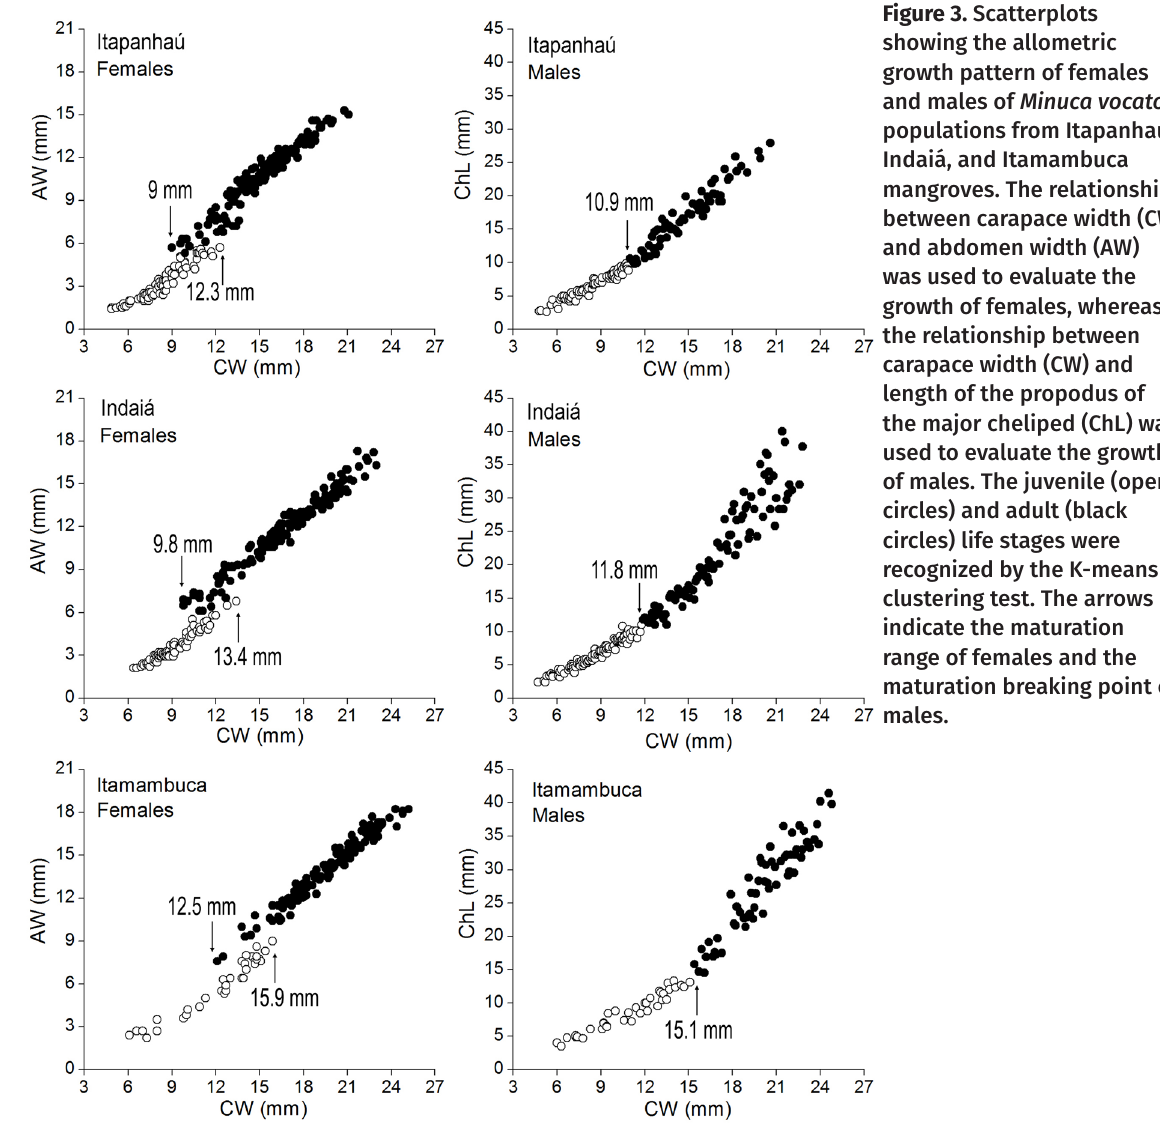
Figure 3. Scatterplots showing the allometric growth pattern of females and males of Minuca vocator populations from Itapanhaú, Indaiá, and Itamambuca mangroves. The relationship between carapace width (CW) and abdomen width (AW) was used to evaluate the growth of females, whereas the relationship between carapace width (CW) and length of the propodus of the major cheliped (ChL) was used to evaluate the growth of males. The juvenile (open circles) and adult (black circles) life stages were recognized by the K-means clustering test. The arrows indicate the maturation range of females and the maturation breaking point of